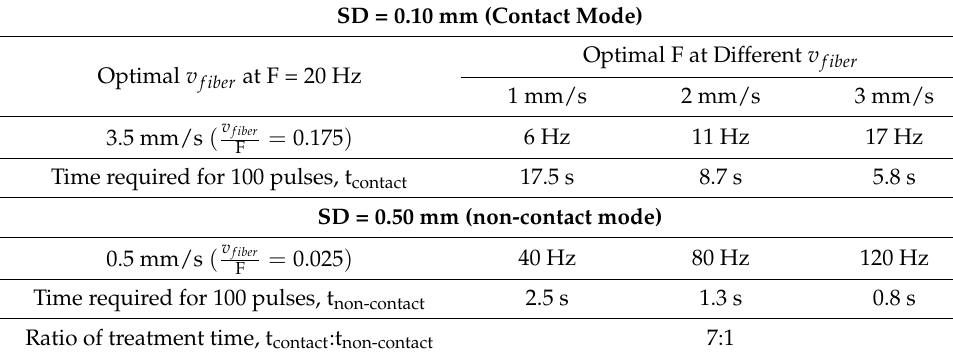
Table 1. Comparison of the optimal pulse repetition frequency (F) and procedure time (t) under three clinically relevant fiber speeds ( v fiber ) as follows 1 mm/s, 2 mm/s, and 3 mm/s at a fiber-to-stone standoff distance (SD) of 0.10 mm (contact mode) and 0.50 mm (non-contact mode).